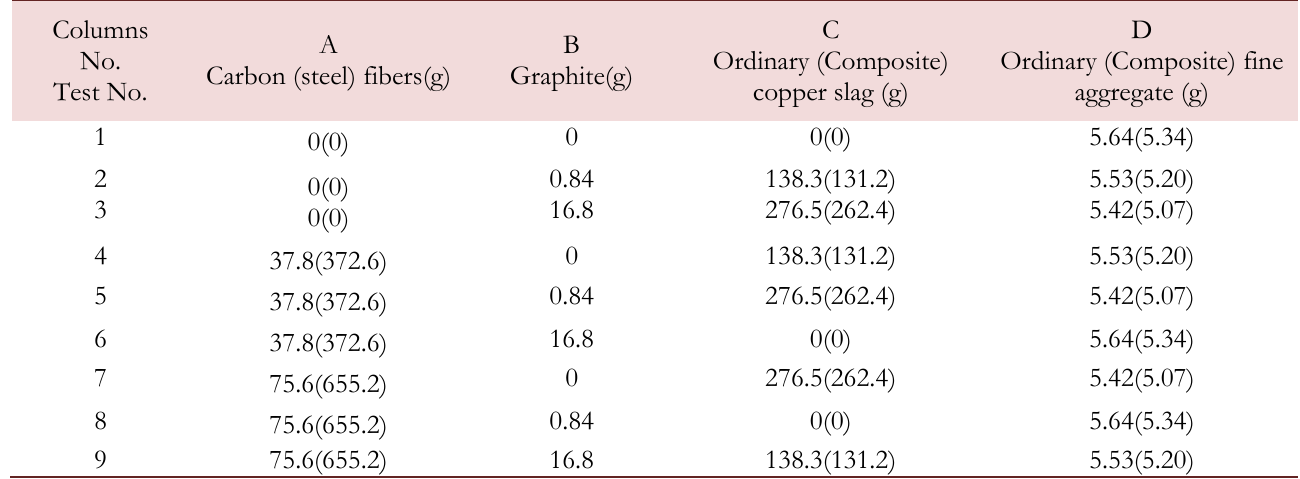
Table 2: Orthogonal Test